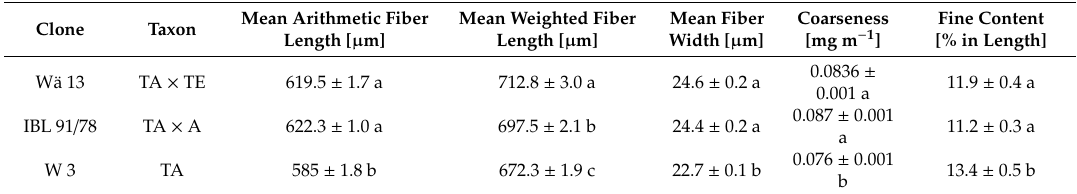
Table 5. Characteristics of the refined pulps (freeness 30 ◦ SR) means ± SE and results of Tukey’s honestly significant di ff erence test. The same lowercase letters indicate statistically homogenous groups at α = 0.05 in Tukey test.